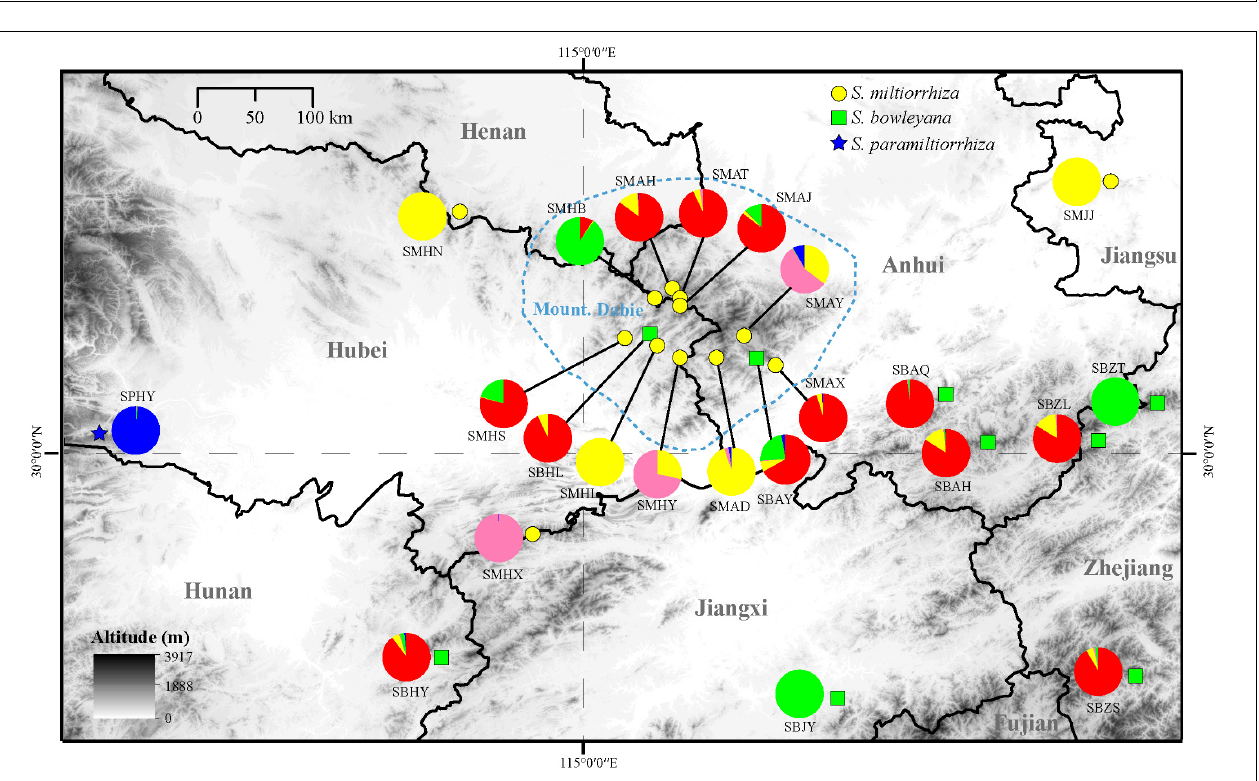
FIGURE 4 | Principal component analysis (PCA) plots showing clustering of samples collected from wild sites. Five ellipse represent the genetic clusters revealed by Admixture analysis ( K = 5), and the color is consistent with the clusters in Figure 3 . (A) PCA1-PCA2 plot; (B) PCA1-PCA3 plot.